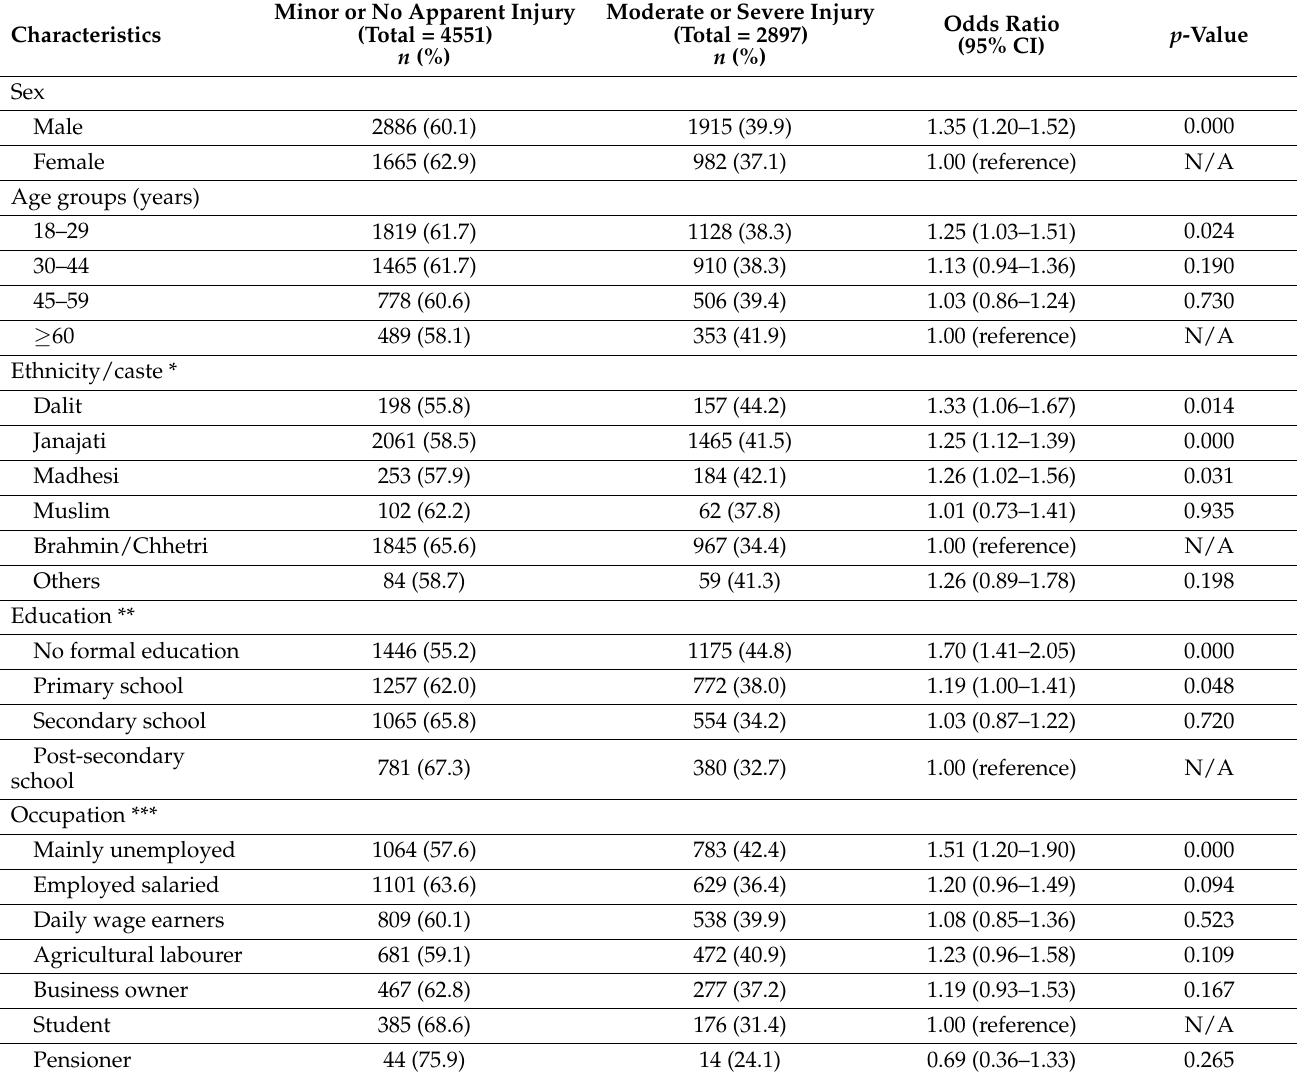
Table 3. Association between sociodemographic variables and injury